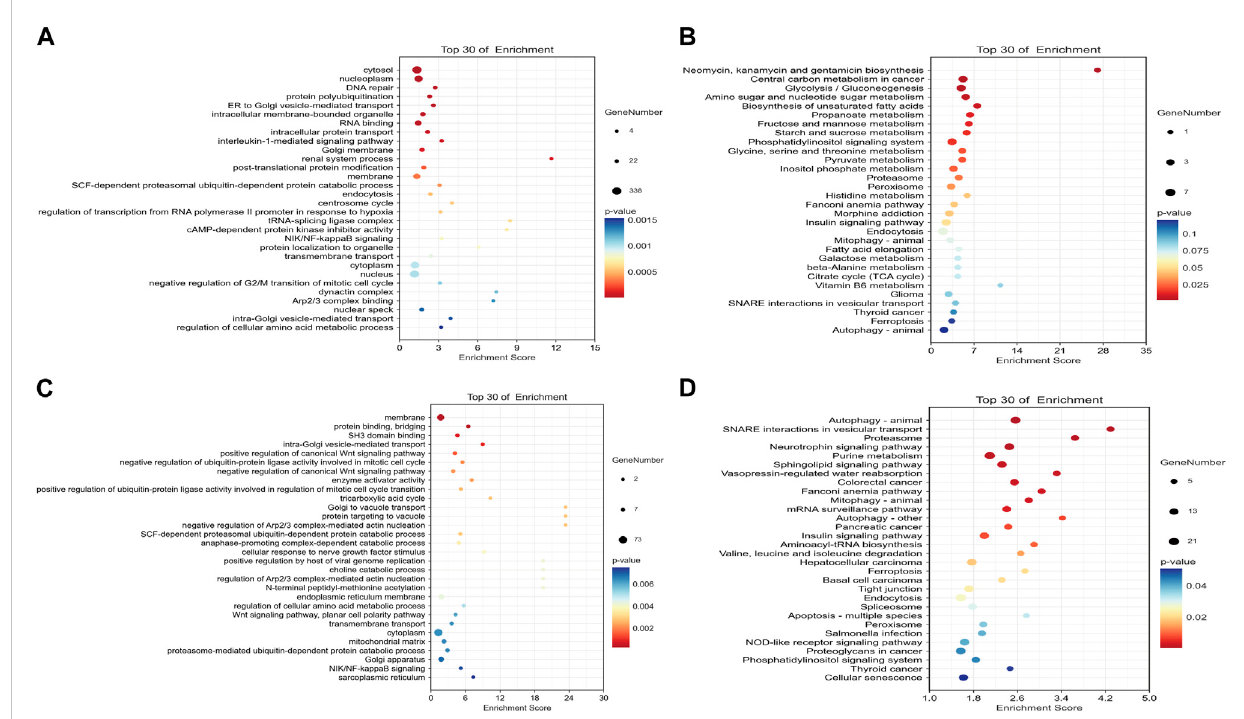
FIGURE 2 Dot plots ofthetop 30mRNAs intheceRNAnetwork. (A) Signi fi cantlydifferentpathways from GO analysis in themRNA – miRNA – circRNAnetwork. (B) Signi fi cantly different pathways from KEGG analyses in the mRNA – miRNA – circRNA network. (C) Signi fi cantly different pathways from GO analysis in the mRNA – miRNA – lncRNA network. (D) Signi fi cantly different pathways from KEGG analysis in the mRNA – miRNA – lncRNA